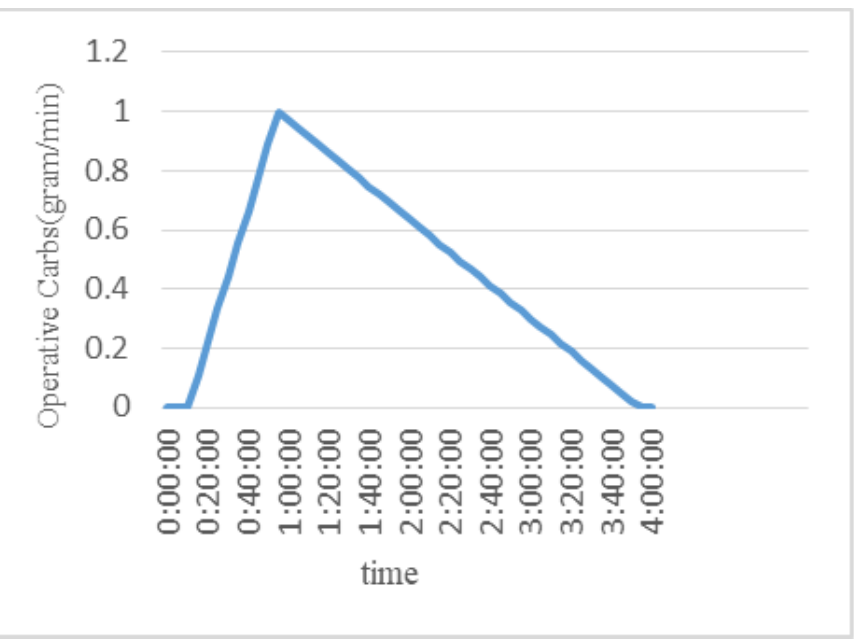
Figure 5. Carbohydrates to the operative carb conversion profile.